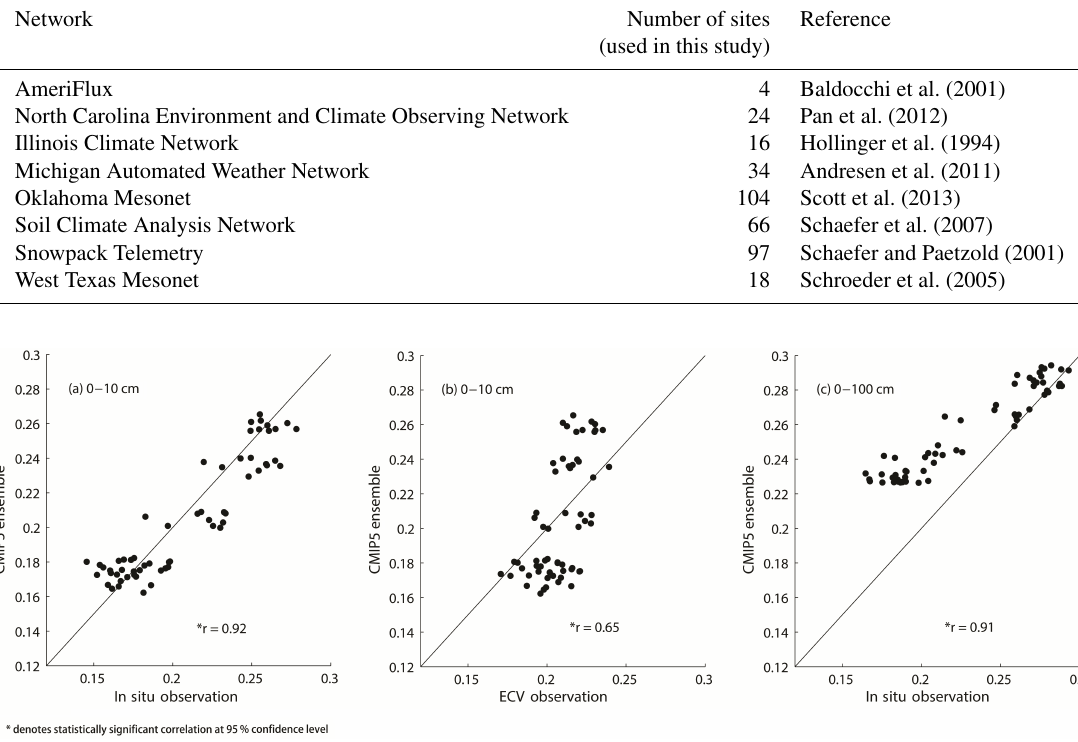
Figure 2. Comparison of soil moisture from the CMIP5 ensemble with in situ and satellite-derived (ECV) soil moisture. Each point represents monthly soil moisture data from the warm season (April to September) that have been spatially averaged over CONUS (2003–2012). Panel (a) indicates CMIP5 ensemble versus in situ observations in the 0–10cm soil layer; (b) CMIP5 ensemble versus ECV in the 0–10cm soil layer; (c) CMIP5 ensemble versus in situ observations in the 0–100cm soil layer during the warm season (April to